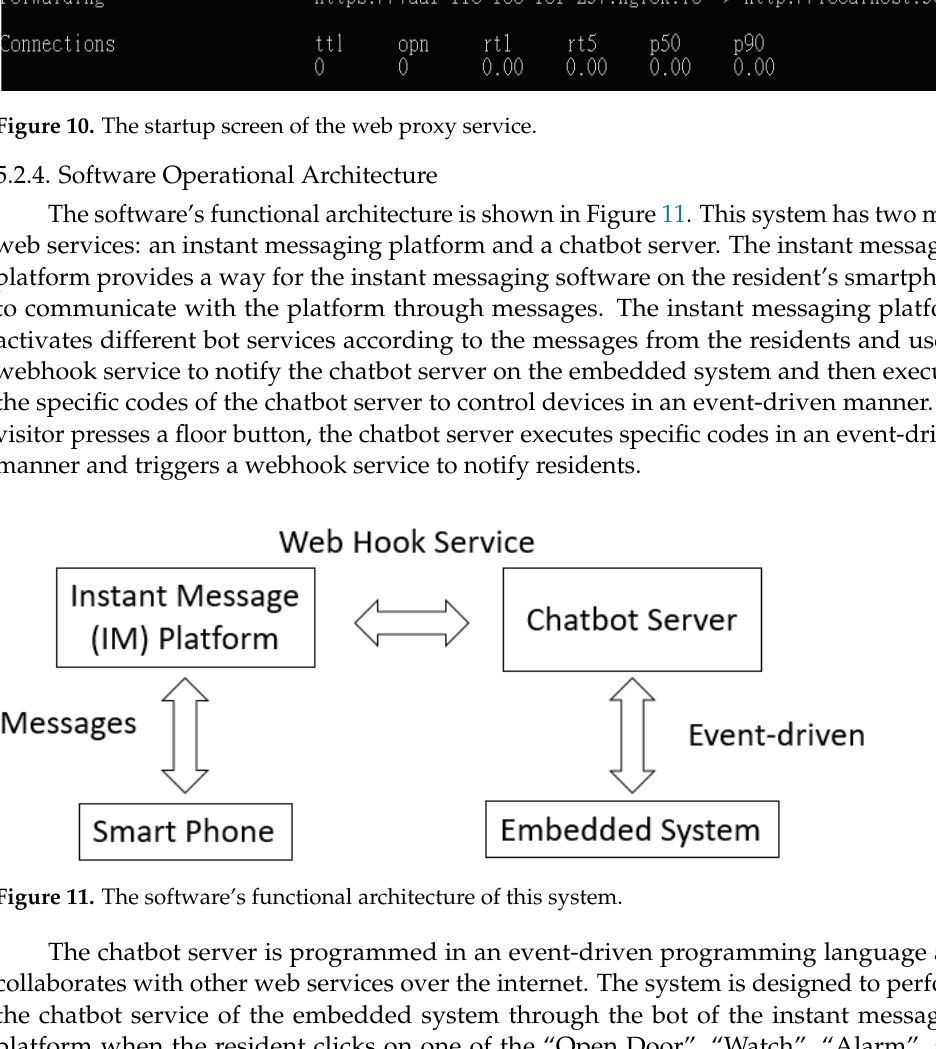
Figure 10. The startup screen of the web proxy service.